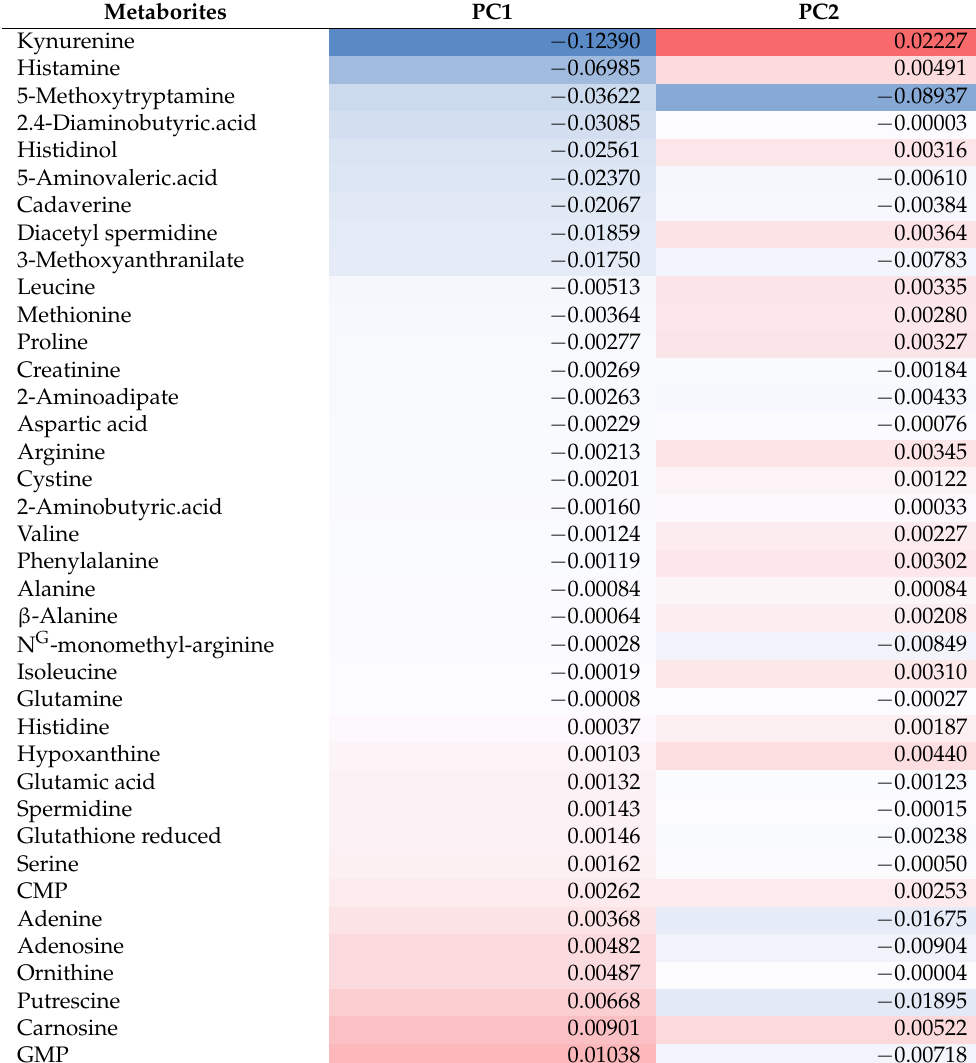
Table 2. Statistically different metabolites in the hippocampus of SAMP10 and ddY